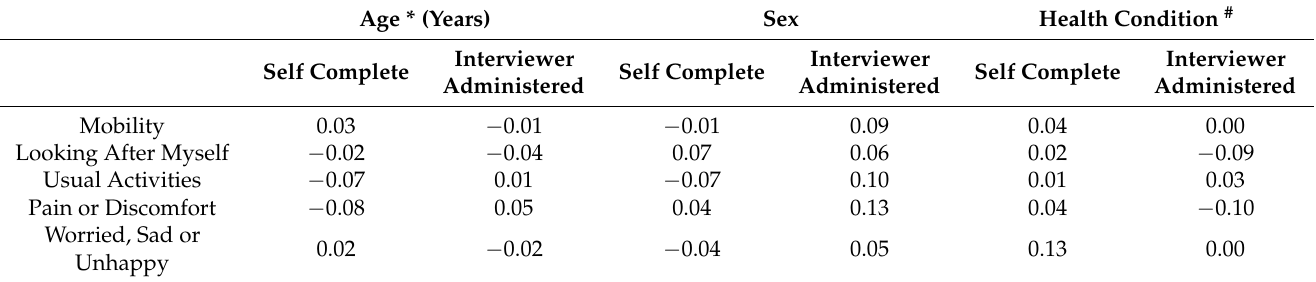
Table 5. Spearman’s rank correlation of self-complete and interviewer-administered scores across health groups, age and